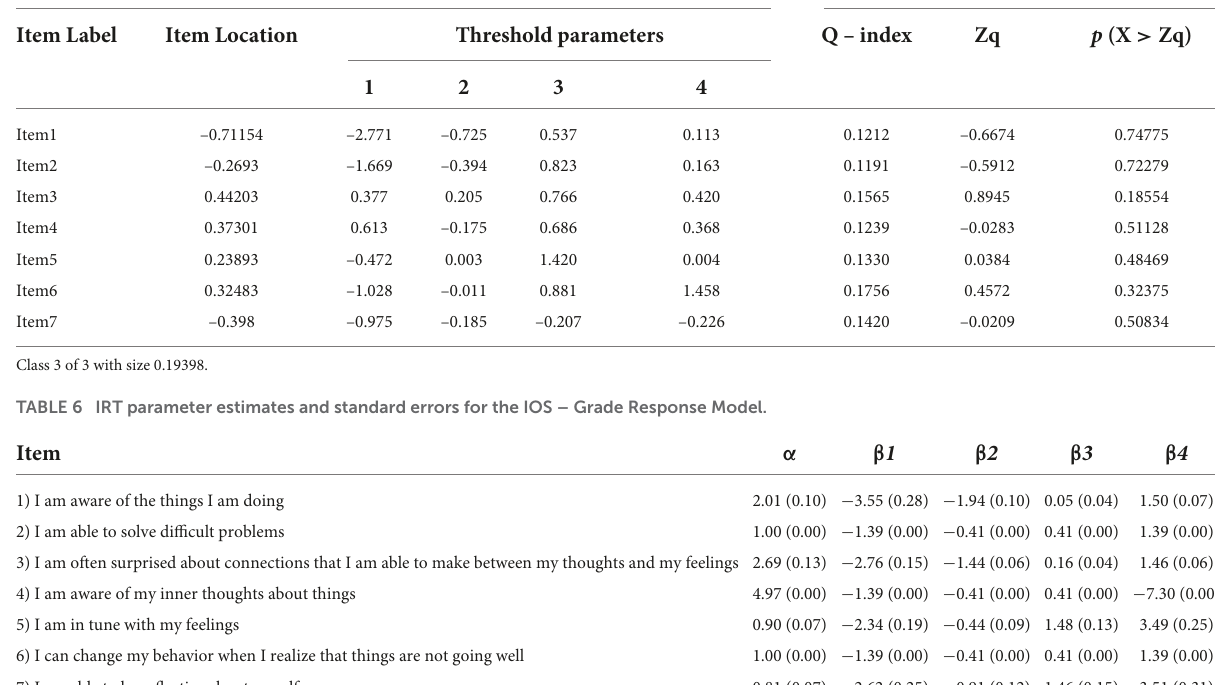
TABLE 5 Item threshold parameters and item fits assessed by the Q-index – Partial Credit Model.